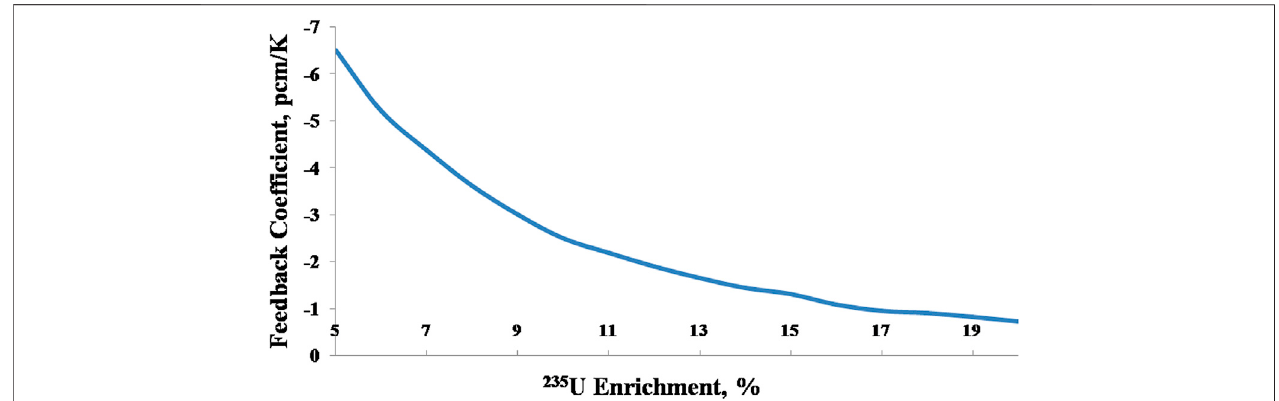
FIGURE 3 | Fuel temperature feedback coef fi cient variation with 235 U enrichment.